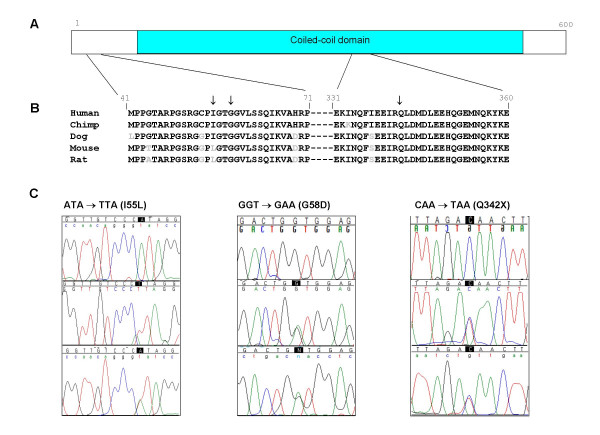
Sequence variants in IFT74 are linked to Chromosome 9p ALS-FTD. (A) Schematic of IFT74's structure. (B) Sequence variants I55L, G58D and Q342X are shown relative to affected protein domains and are indicated by black arrowheads. Human IFT74 protein aligned with other orthologs from chimpanzee (XP_520518.1), dog (XP_531964.1), mouse (AAH23760.1) and rat (NP_001007002.1). Amino acid number is based on the human protein. (C) chromatograms showing wild type (top), forward mutant (middle) and reverse mutant (bottom) sequences of I55L (left), G58D (middle) and Q342X (right).